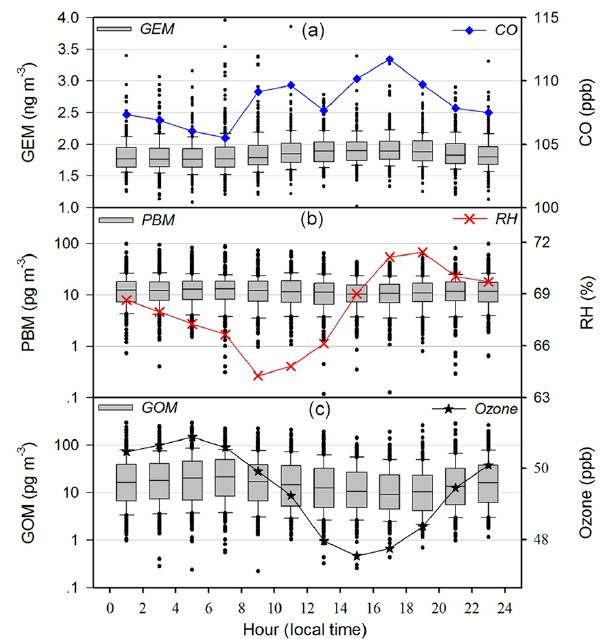
Figure 2. Diel, 2h averaged, variations of atmospheric GEM and CO (a) ; PBM and relative humidity (RH; b ); and GOM and ozone (c) at the PDM Observatory. Box lines indicate the 10th, 25th, 50th, 75th, 90th percentiles, and data points indicate concentrations be- low 10th and above 90th